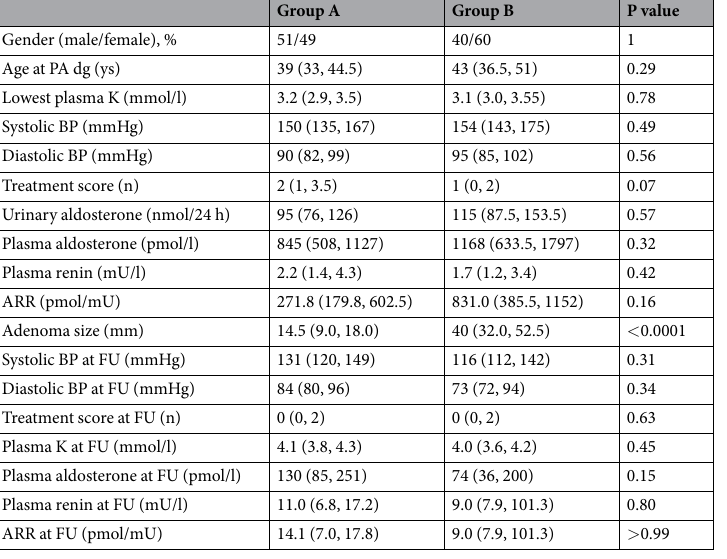
Table 1. Clinical and biochemical correlates of patients from group A and B. PA: primary aldosteronism; HTN: hypertension; K: potassium; BP: blood pressure; ARR: aldosterone to renin ratio; FU: follow-up. Categorical data reported as number (percentage) and compared with Fischer’s exact test; quantitative data reported as median (interquartile range) and compared with the Mann-Whitney test (p significant if <